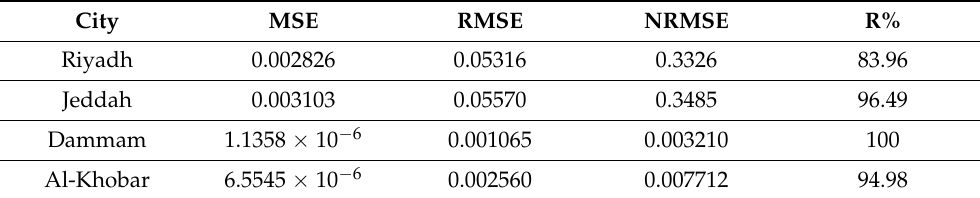
Table 4. ANN model results in the testing phase.